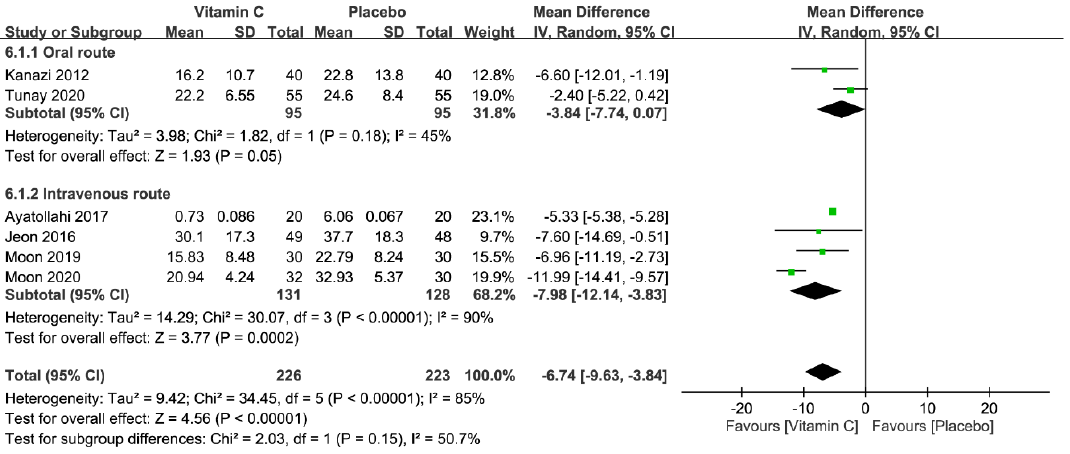
Figure 9. Forest plot for the comparison of opioid consumption (mg) within postoperative 24 h between vitamin and placebo groups. CI, confidence interval; IV, inverse variance.